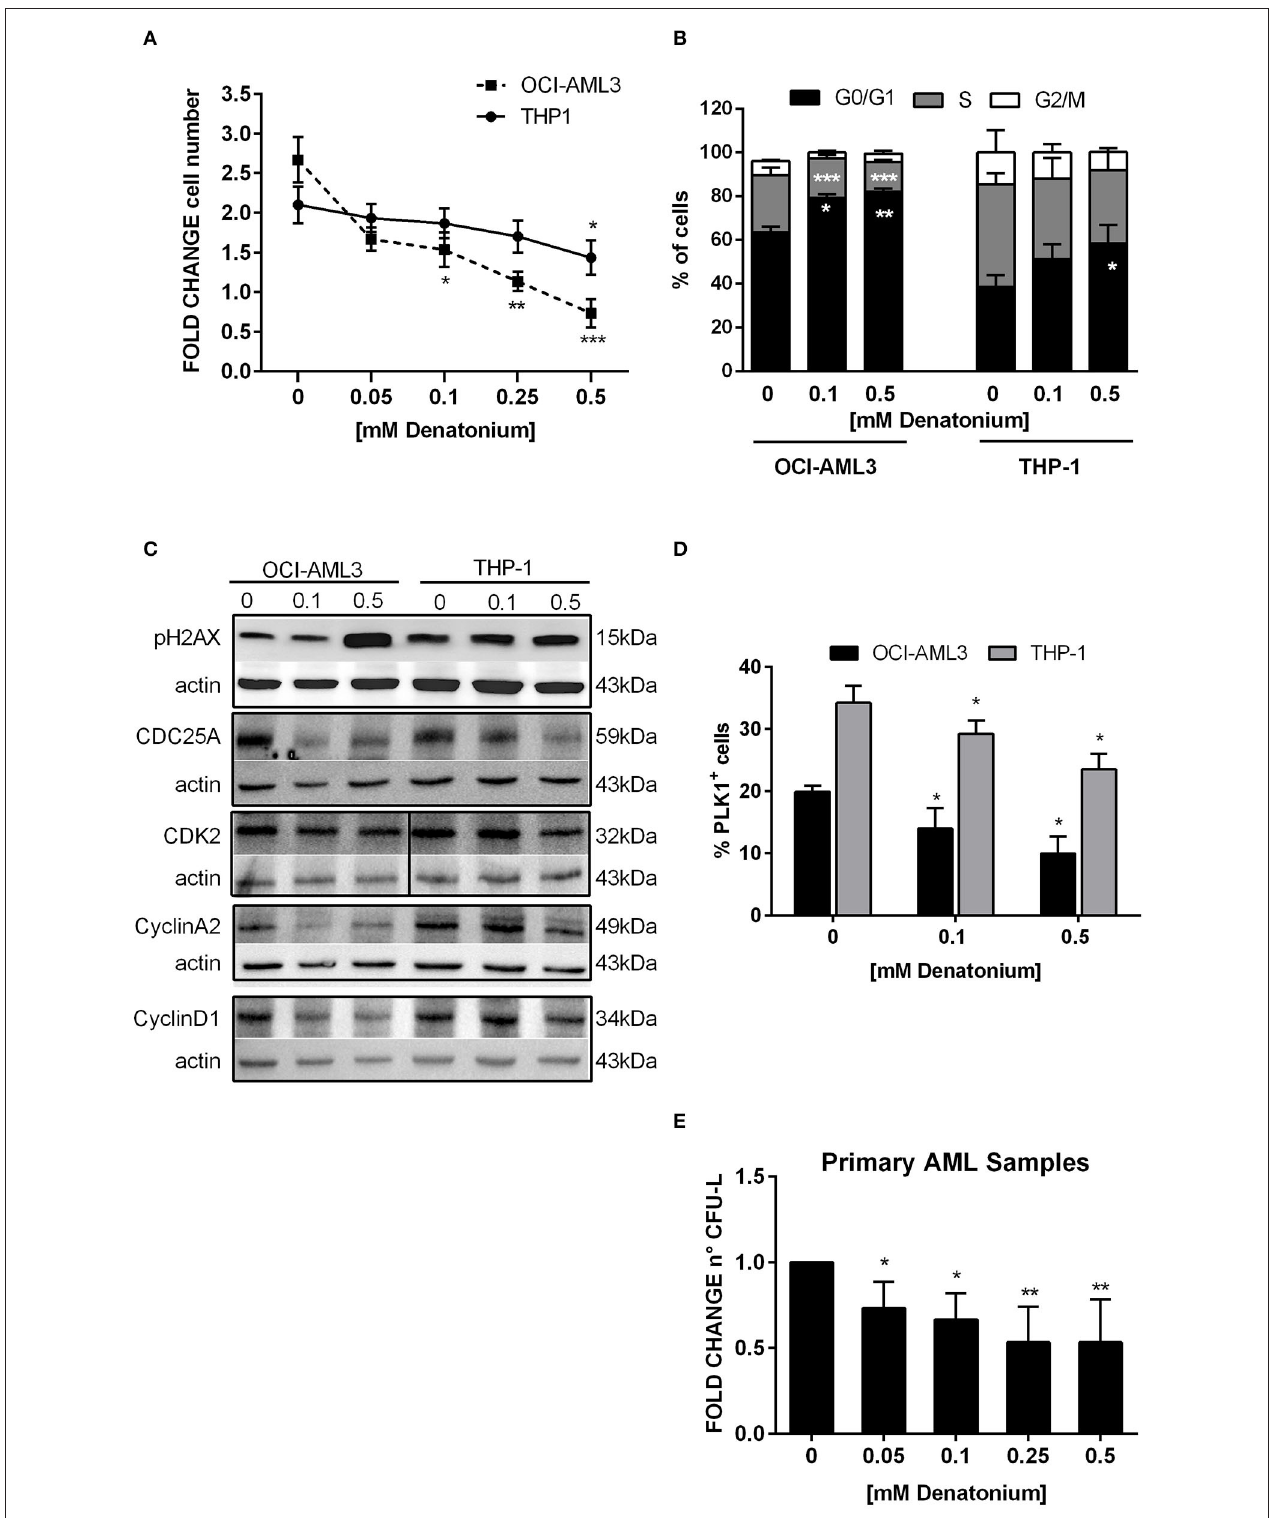
FIGURE 5 | DEN stimulation inhibits AML cell proliferation and clonogenic ability. (A) Cell proliferation determined by CellTiter 96 Aqueous One Solution assay and normalized to time 0 in THP-1 ( n = 3) and OCI-AML3 ( n = 3) cultured for 48h with increasing doses of DEN. (B) Histograms display cell cycle phase distribution